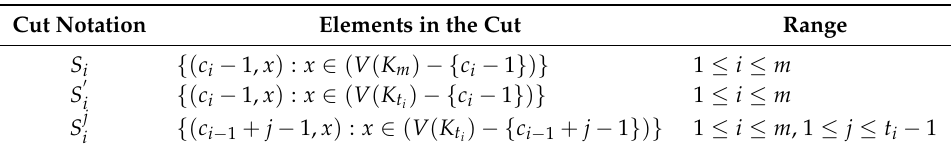
Table 3. Edge cuts in circular necklace